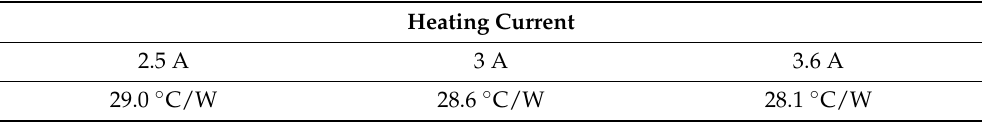
Table 6. Values of Zth ( I g TSEP).